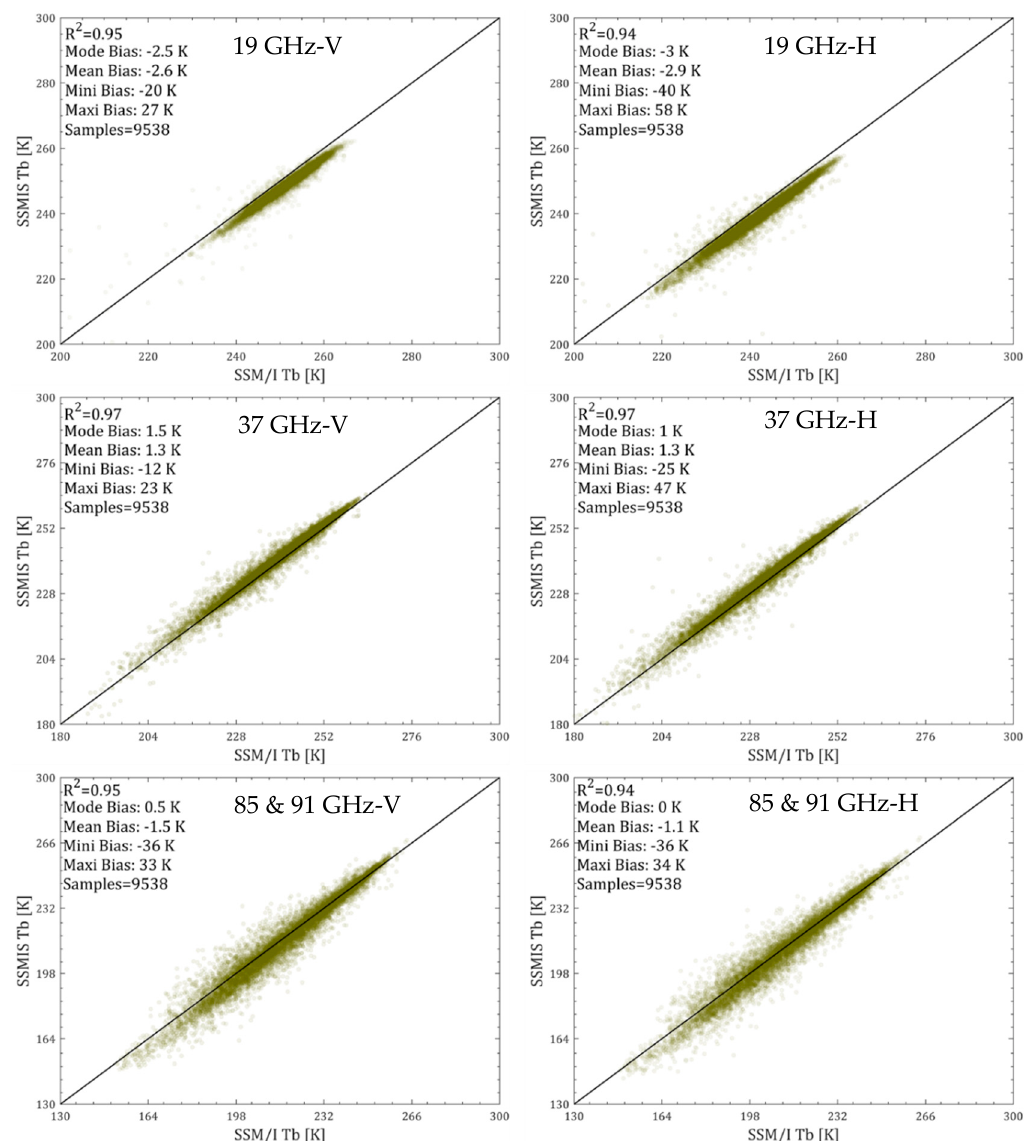
Figure 2. Scatter plots of brightness temperature between SSM / I and SSMIS in snow-covered areas based on weather station observations, including 19.35 GHz (top), 37 GHz (middle), and 85.5 (91.655) GHz (bottom). Left: H-polarization; right: V-polarization.